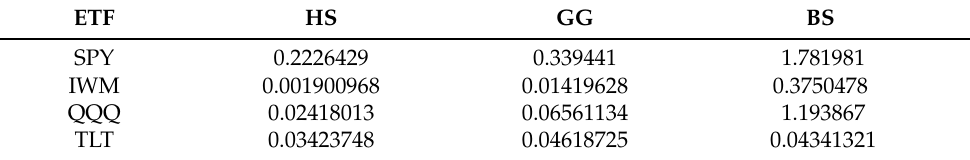
Table 2. Model’s goodness-of-fit as measured the respective MSE for each of the four ETFs. ETF HS GG BS